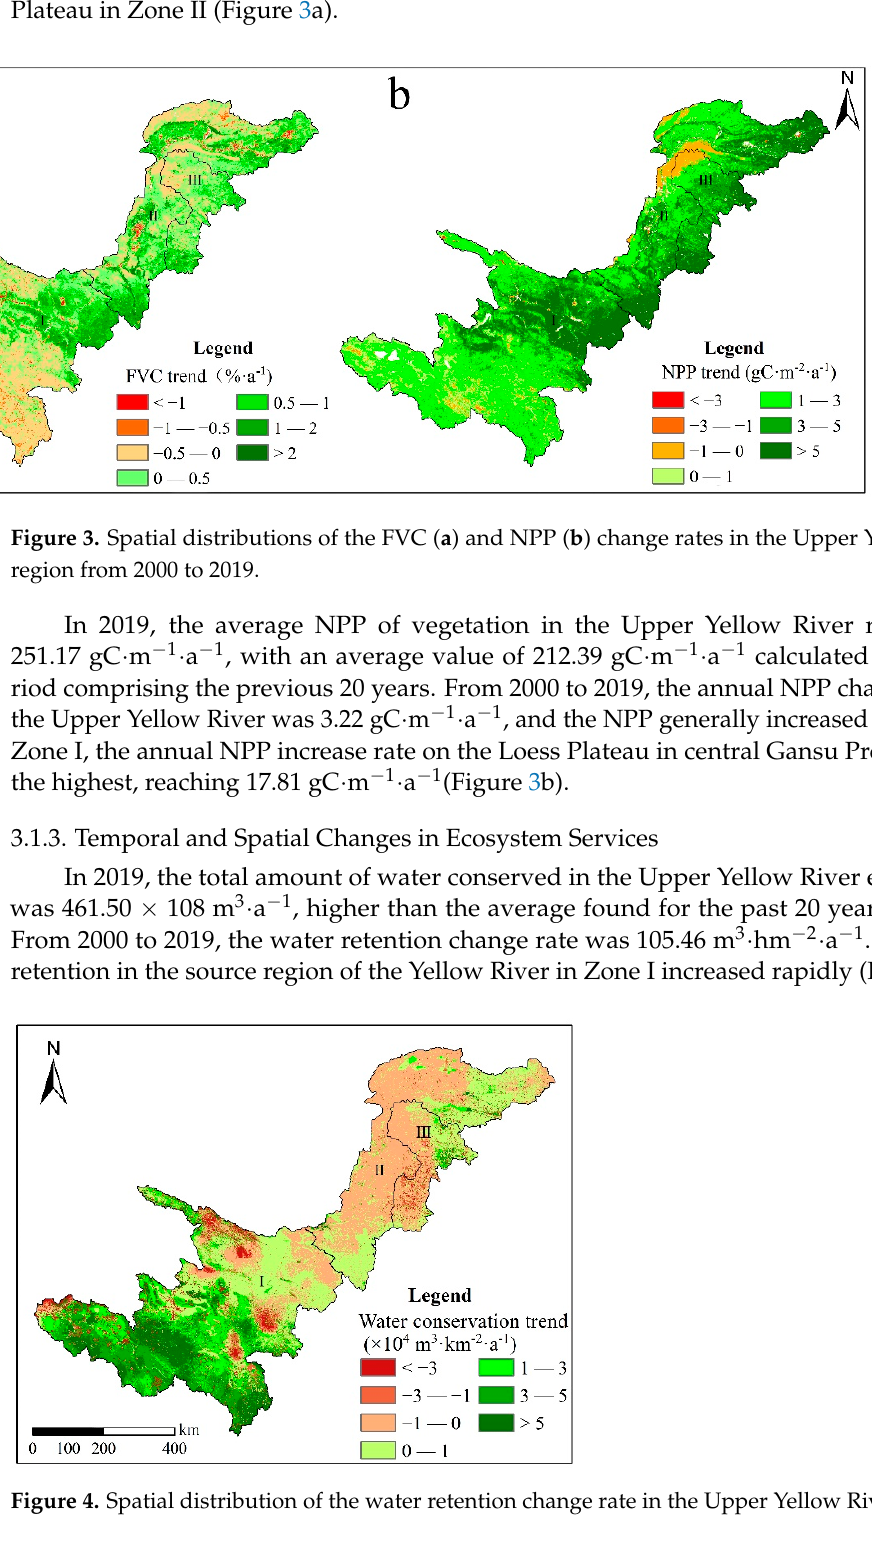
10 of 22 Figure 2. Areal changes of various ecosystem types in the Upper Yellow River region from 2000 to 2010 and from 2010 to 2018.